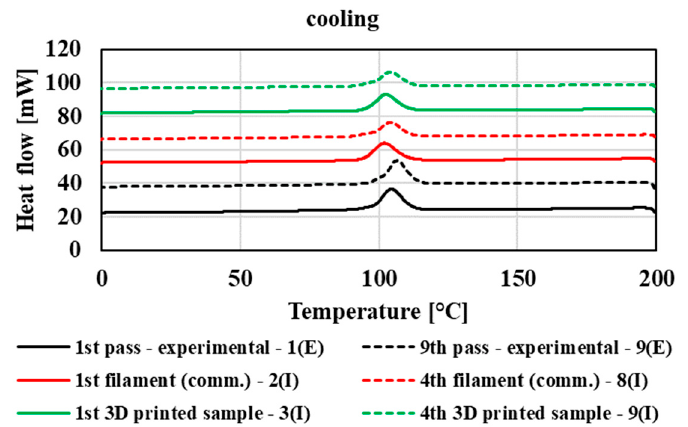
Figure 13. DSC thermogram of cooling heating for experimental and commercial type polymeric material.